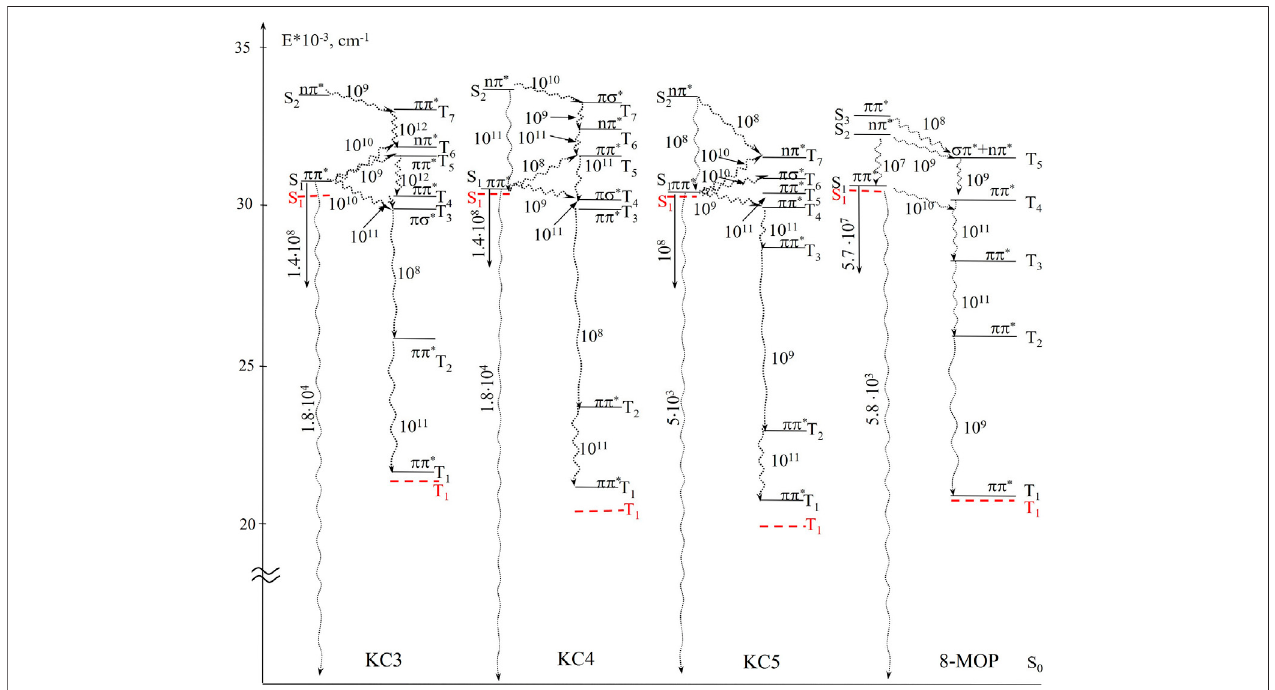
FIGURE4| Diagramsofelectronicallyexcitedstatesofthecompounds(dashedlinesindicateexperimentalvalues).Arrowsshowthewaysofenergyrelaxation,the numbers near them are the rate constants of these processes, s − 1 .